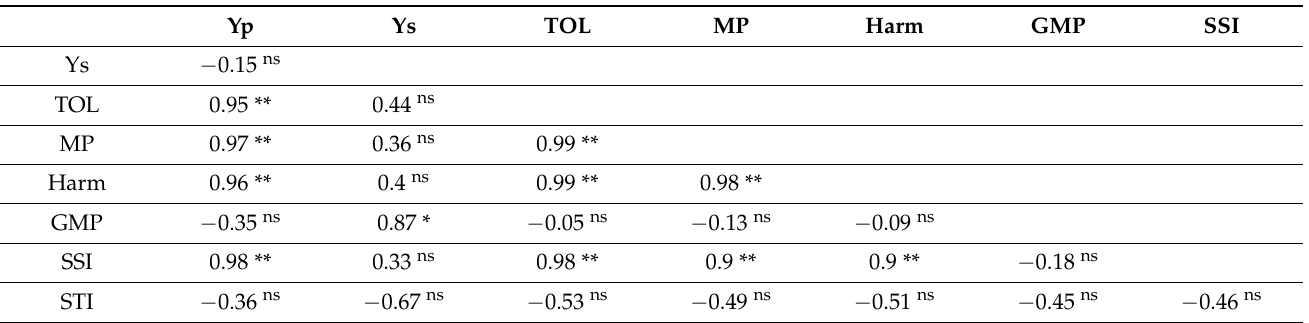
Table 6. Correlation coefficients between drought-tolerance indices evaluated under water stress conditions.